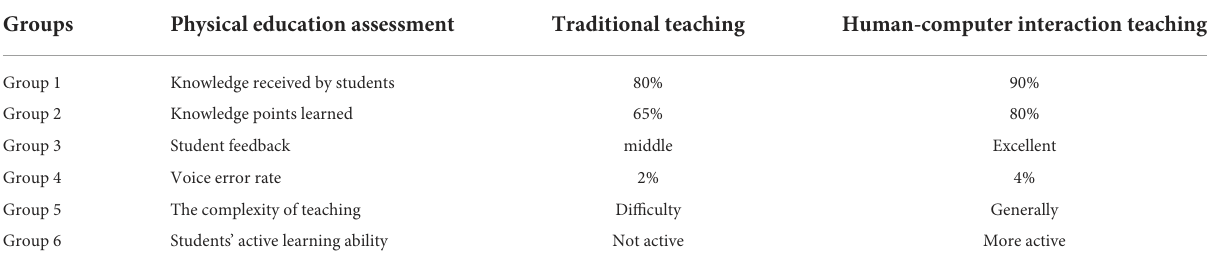
TABLE 2 Two models of physical education teaching and